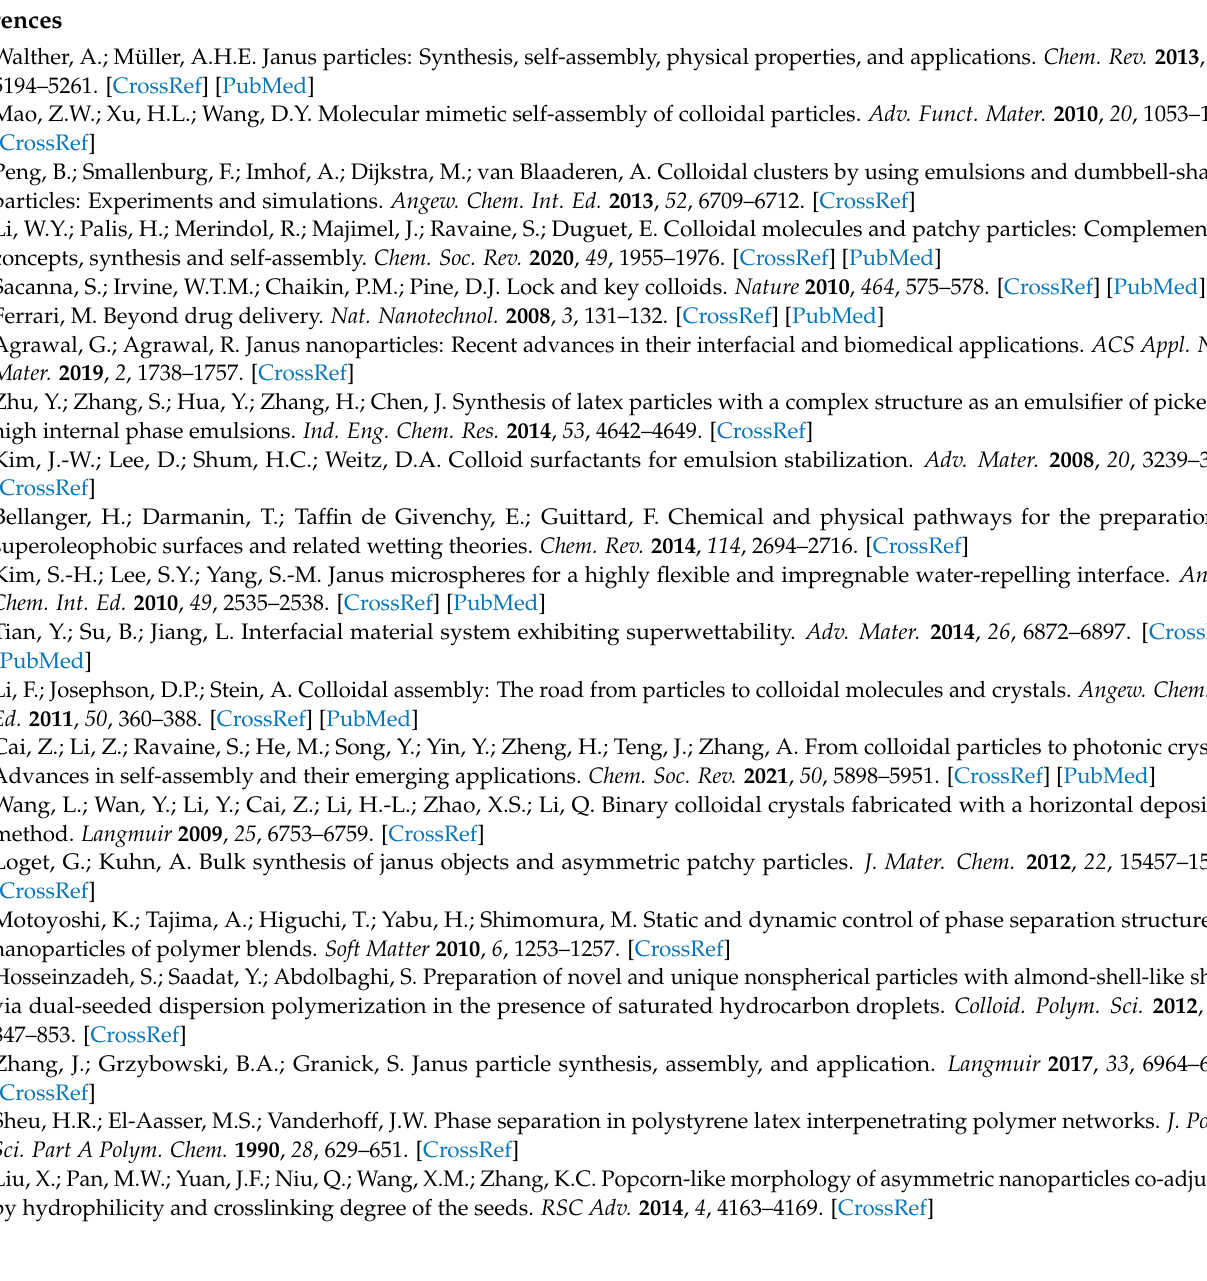
Figure S2: Water contact angles of coatings with PS/P(OFMA-S) composite particles obtained with different w OFMA / w St of 1/4, 1/2, 1/1, 2/1 and